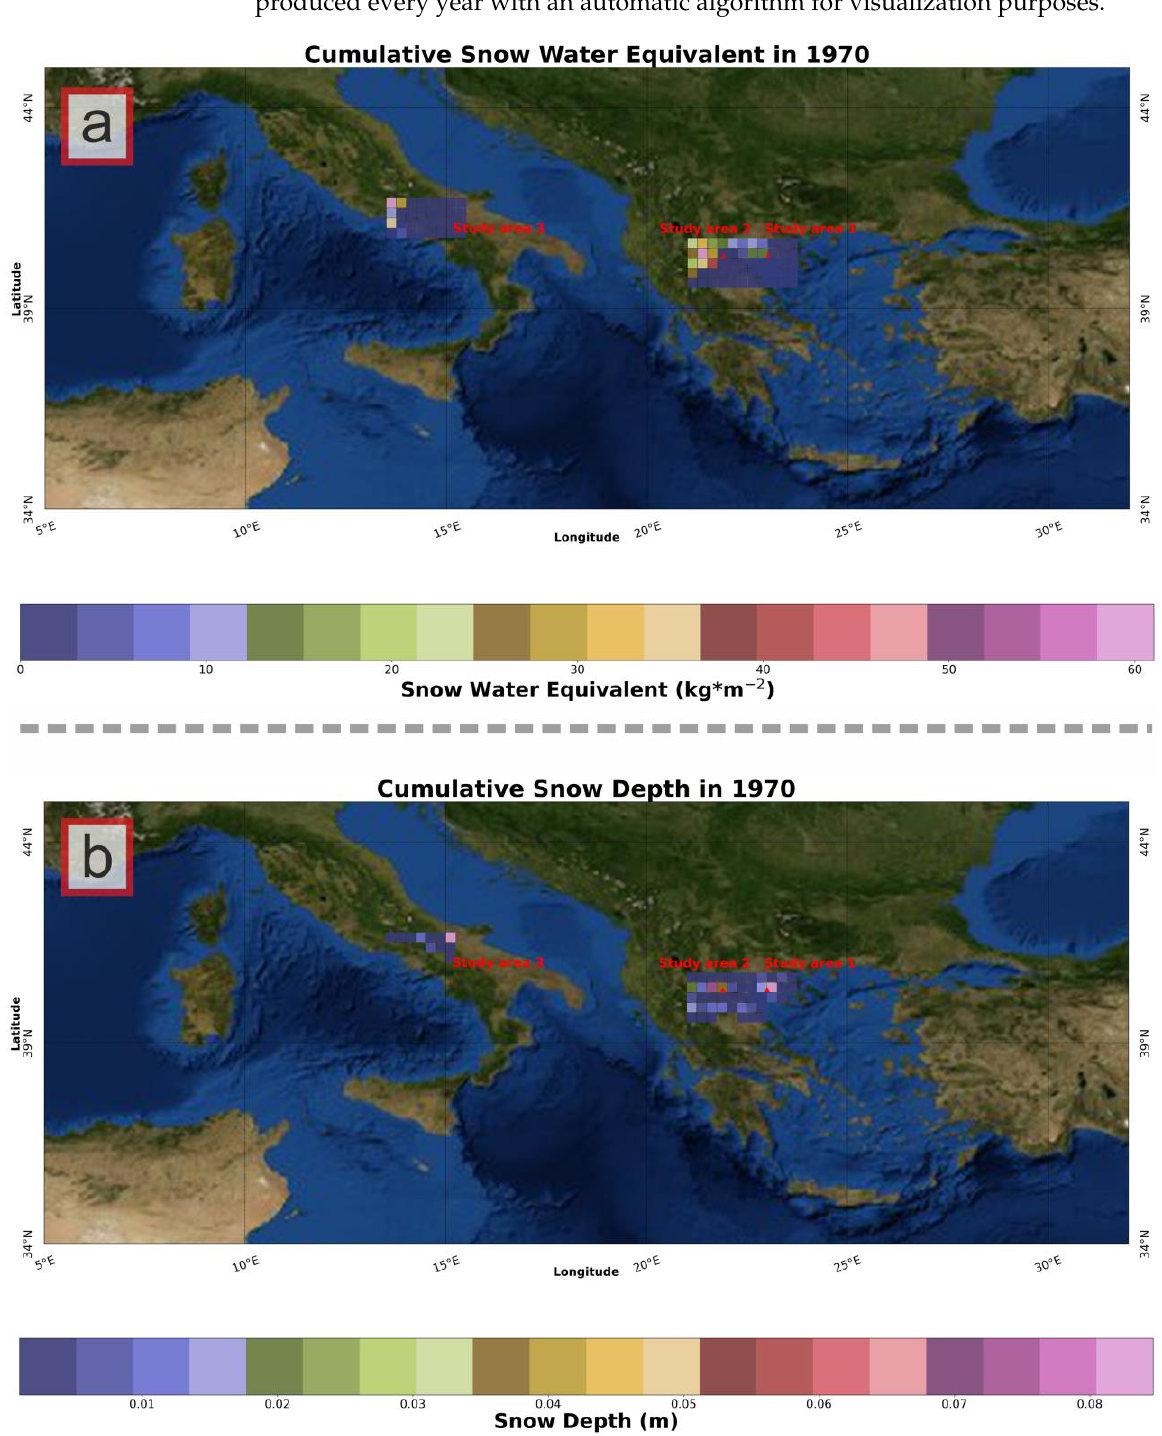
Figure 3. Cumulative ( a ) snow water equivalent (kg/m 2 ) and ( b )snow depth (m)in 1970 over the study areas.